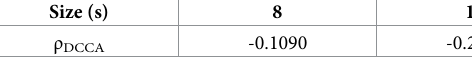
liquidity in China are persistent or have long-term memory in the short term. Moreover, the cross-correlation exponent between SHIBOR and SHSML is less than 0.5 when s > s � , which means that there are antipersistent cross-correlations between the money market rate and stock market liquidity in the long term. In addition, Table 3 shows that the antipersis- tence between the money market rate and stock market liquidity in the long run is much greater than the persistence in the short run. Therefore, the relationship between the money market rate and stock market liquidity in China is nonlinear and dynamic. Specifically, the money market rate and stock market liquidity in China have the same changing trend in the short term, money market rate cuts will lead to an increase in stock market liquidity in the long term, and the negative impact of the money market rate on stock market liquidity is more significant than the positive implication.